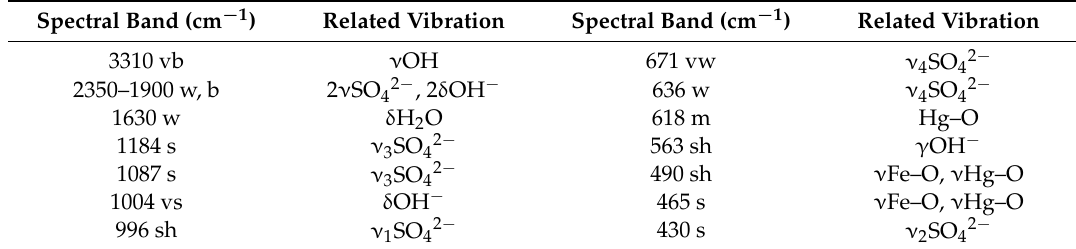
Table 2. FTIR spectral analysis of the synthetic mercury